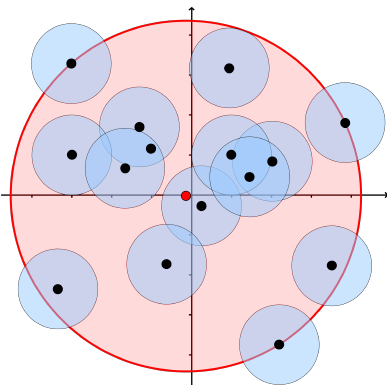
Figure 8. The miniball of the point cloud N